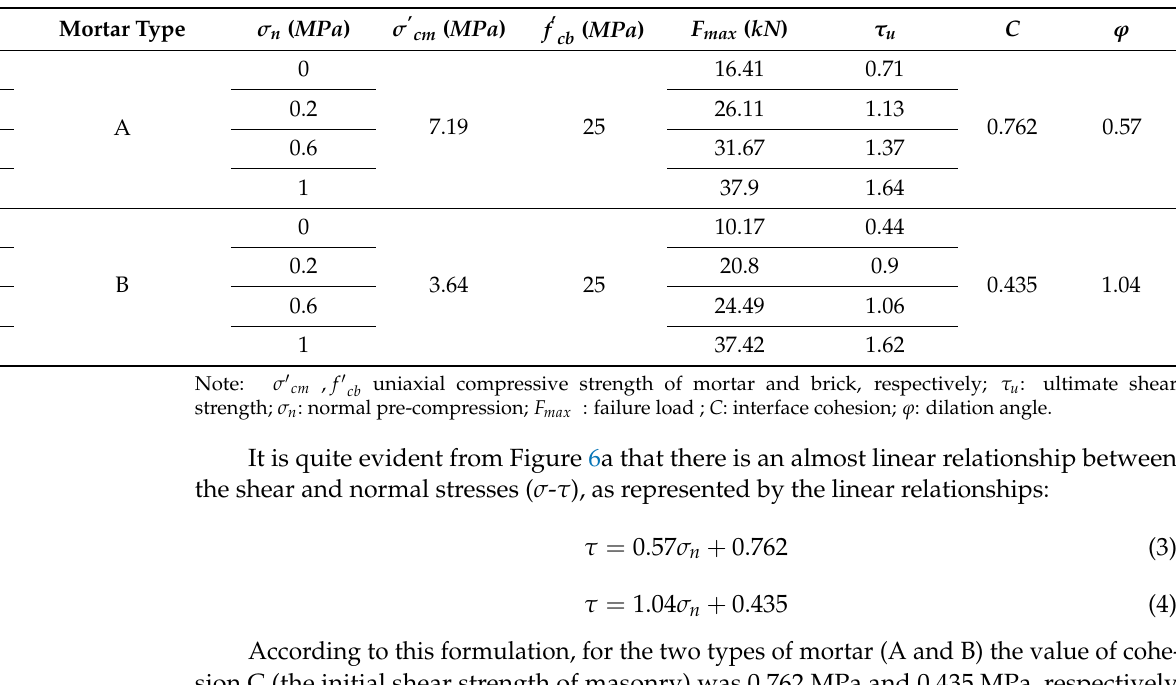
Table 4. Shear strength parameters from triplet shear